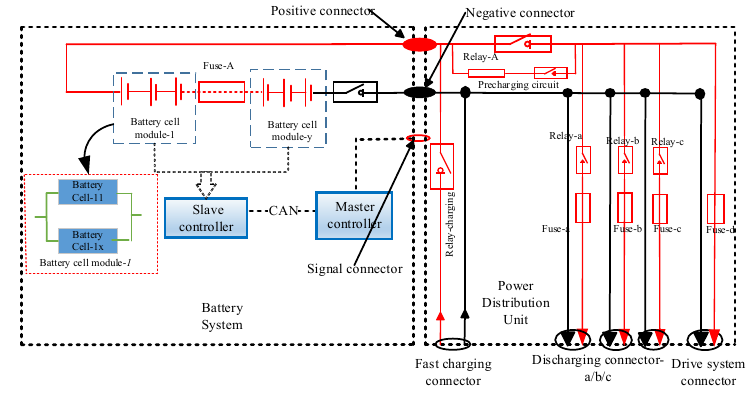
Figure 3. Schematic diagram of the battery system and PDU.